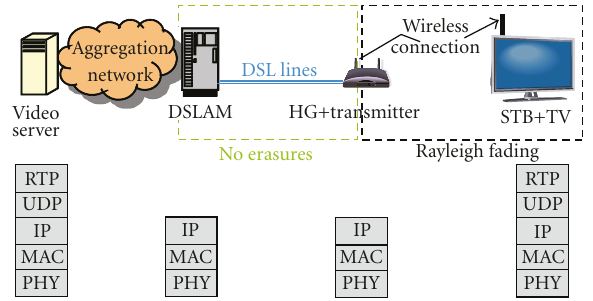
Figure 1: Concatenation of DSL connection and wireless connec- tion (DSLAM = digital subscriber line access multiplexer, HG = home gateway, STB = set-top box).